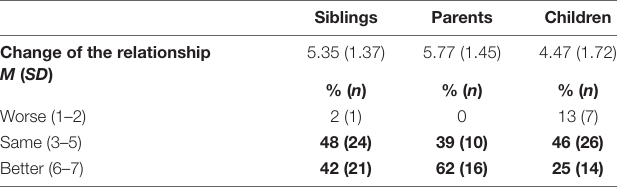
TABLE 6 | Change of relationship quality following the coming